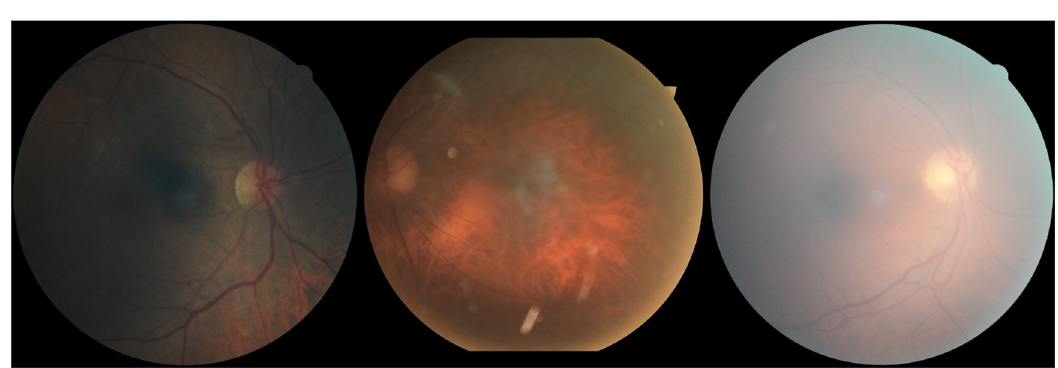
Fig 1. Ungradable images. Examples of ungradable images because they are either out of focus, under-, or